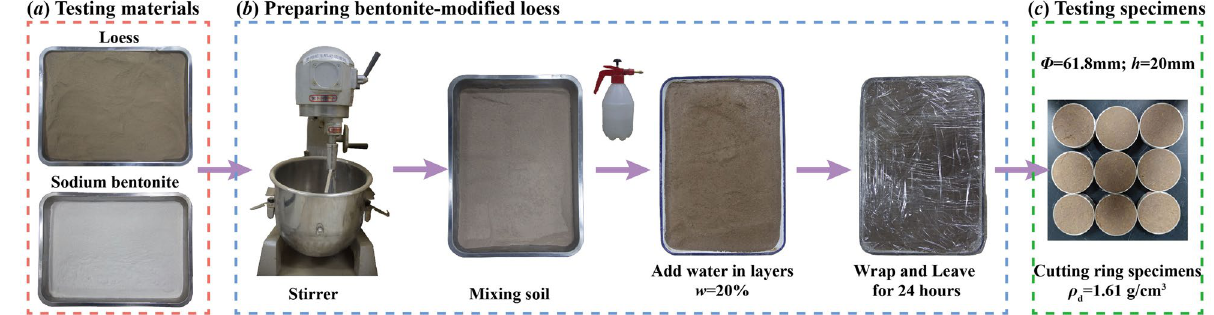
Figure 2. The preparation process of bentonite modified